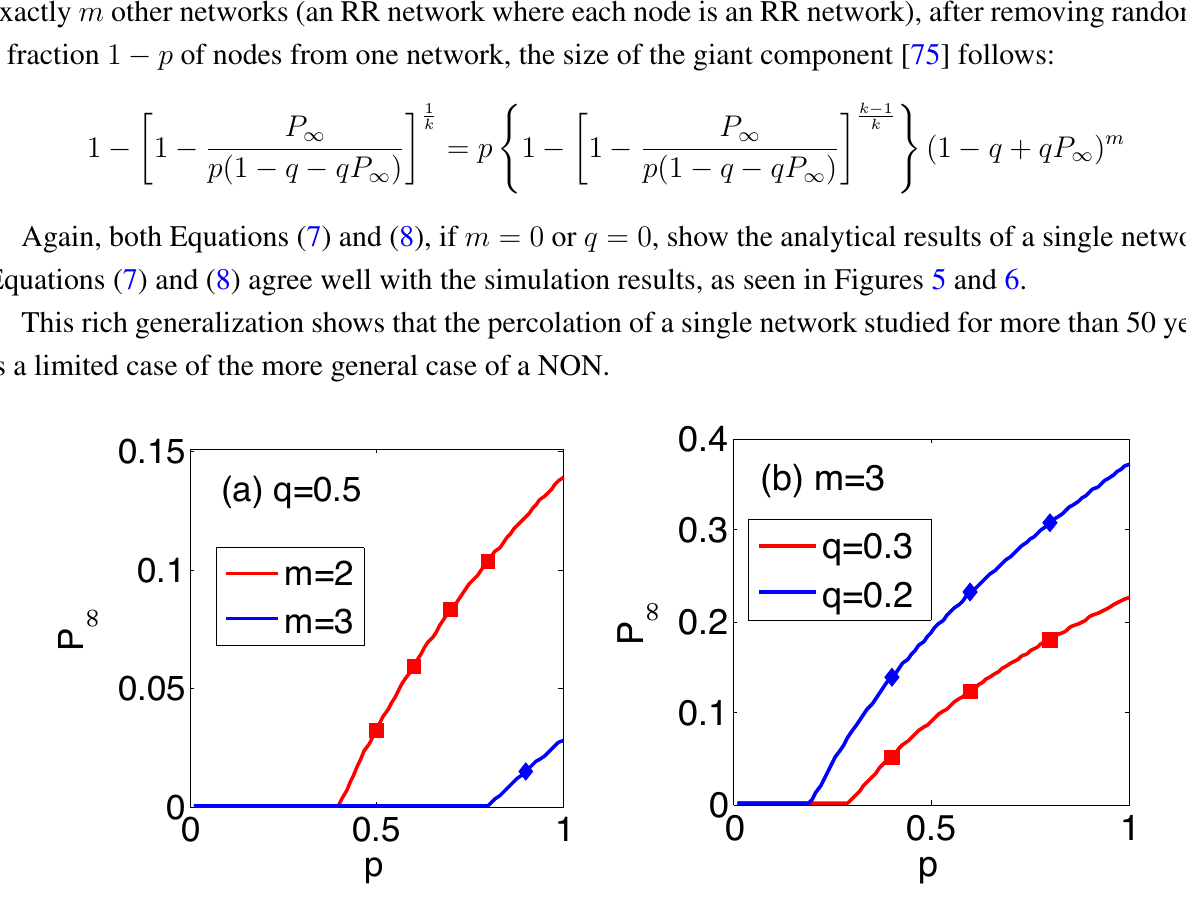
Figure 5. The giant component for an RR network of ER networks with feedback condition P as a function of p for ER average degree (cid:104) k (cid:105) = 10 , for different values of m when q = 0 . 5 ∞ and ( a ) for different values of q when m = 3 . The curves in (a) and ( b ) are obtained using Equation (7) and are in excellent agreement with the simulations (symbols). The symbols are obtained from simulations of an NON with n = 6 networks forming a circle by averaging over 20 realizations with N = 2 × 10 5 with both cases m = 2 and m = 3 . The